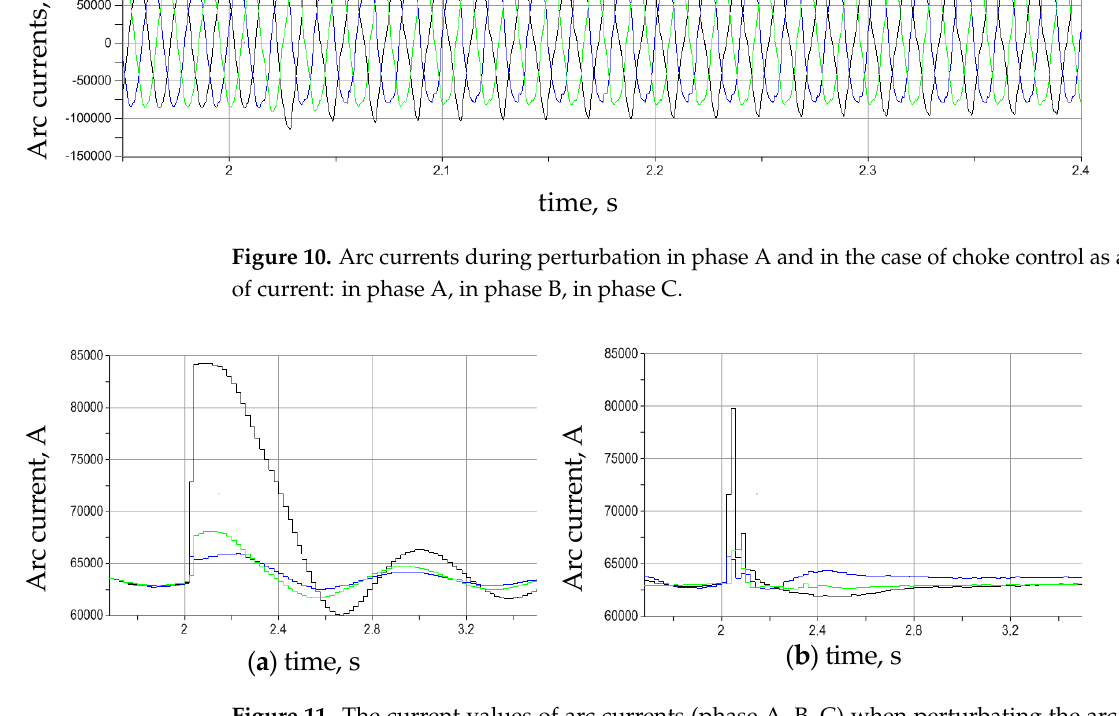
Figure 11. The current values of arc currents (phase A, B, C) when perturbating the arc length in phase A, in the case of ( a )—without choke control, ( b )—with choke control as a function of current: in phase A, in phase B, in phase C.